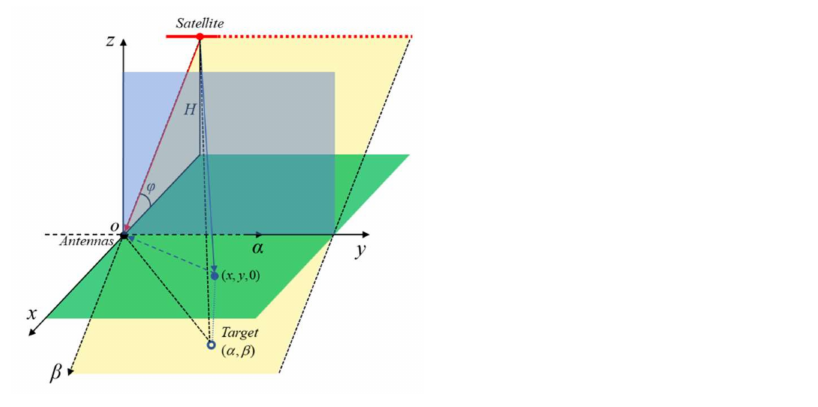
Figure 6. Imaging geometry of the developed SDR MF-PB-SAR system with the satellite height H = 693 km and the incident angle ϕ of the satellite obtained from the Heavens Above website. The target in the x-o-y plane is projected on the α -o- β plane for imaging